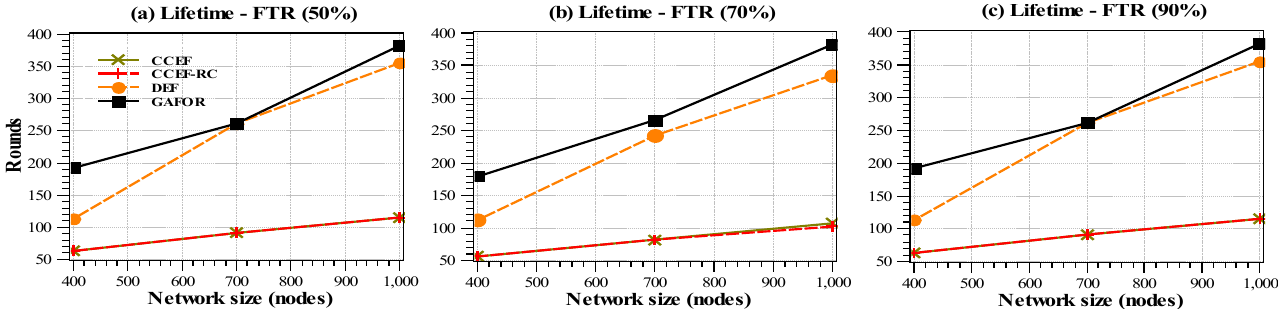
Figure 10. Network lifetime (FTR 50, 70, and 90% at first node depleted (FND)).